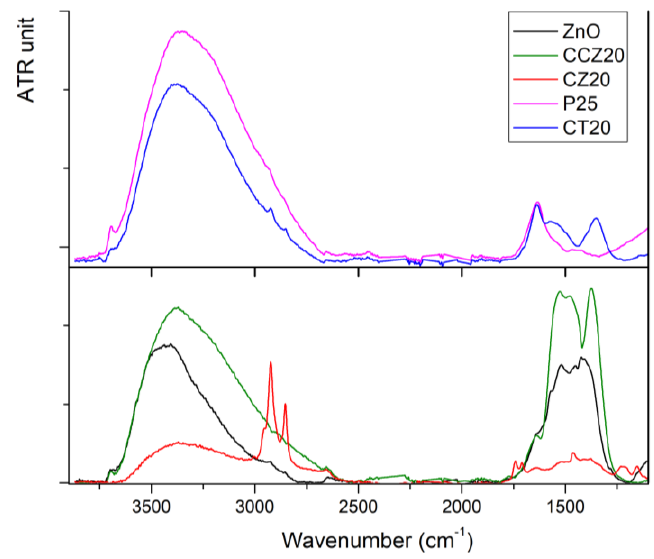
Figure 8. ATR spectra in the spectral range 3800 – 1000 cm −1 .